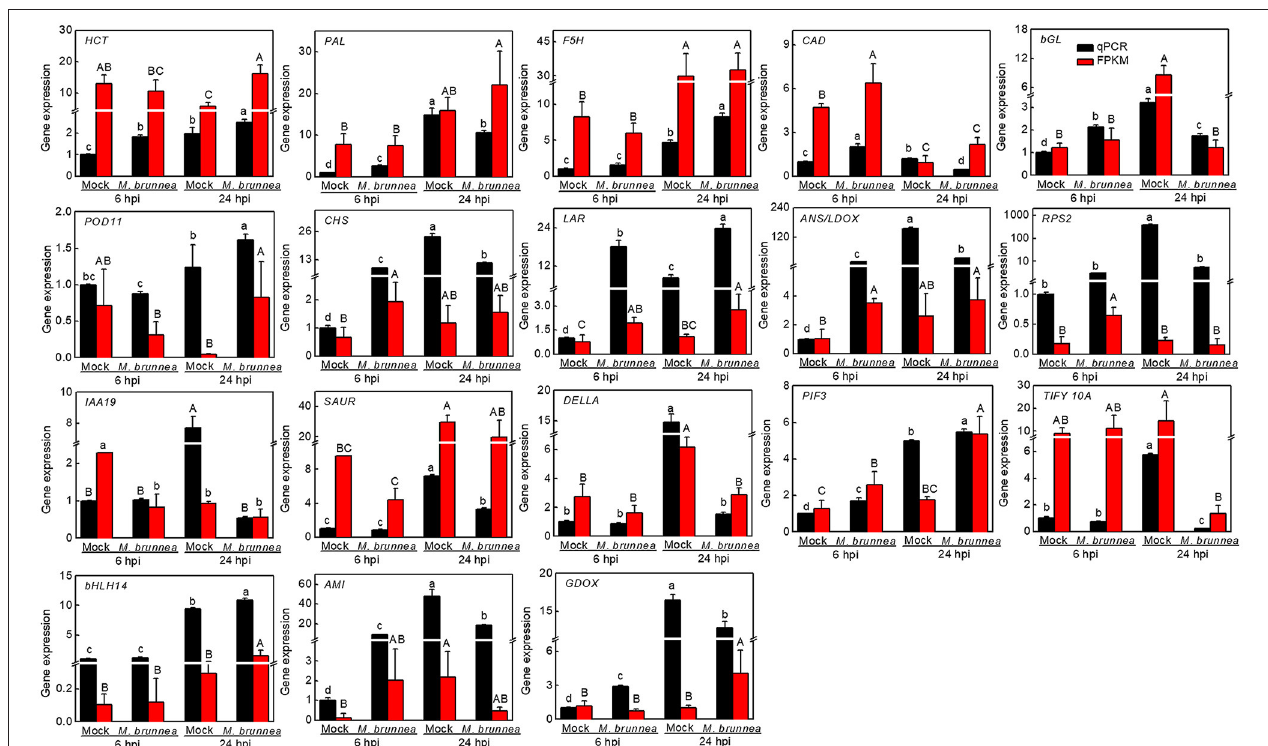
FIGURE 3 | Quantitative PCR (qPCR) verifies the quality of transcriptome sequencing using the 2 − 11 Ct method. The black bar represents the qPCR validation result of mRNA in the sample, with positive and negative error bars; and the red bar represents the normalized result (FPKM) of the sample in the transcriptome. The results of qPCR are presented as mean values ± SD; n = 3. The results of FPKM are presented as mean values; n = 3. Lowercase letters indicate significant differences in qPCR results between treatments, with capital letters for FPKM values ( P <